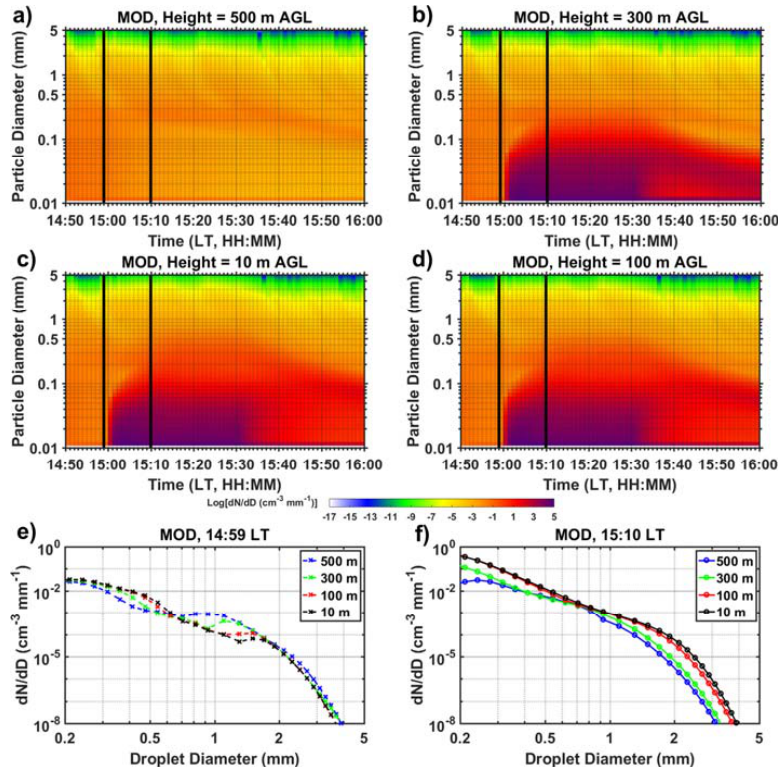
Figure S1a, the large number of collisions for low p = d 2 moves the collision outcomes dynamics from Regime II that is dominated by breakup dynamics to Regime I where coalescence and filament breakup compete. This results in a net decrease in breakup efficiency compared to light rainfall without SFI, and a significant increase in the number concentration of drops >0.7 mm, corresponding to changes in raindrops between 1 and 2 mm by one order of magnitude (e.g., Figure 9e,f). Because the most significant differences in rainfall spectra with and without fog are found for small and intermediate size raindrops, this represents a significant detection challenge to radar measurements (Figure S1b).